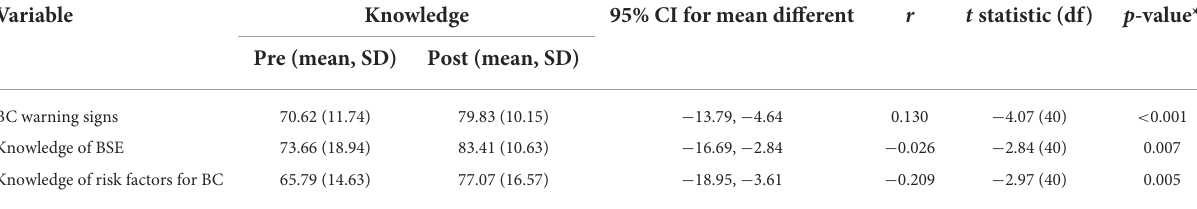
TABLE 2 Breast cancer awareness ( n =